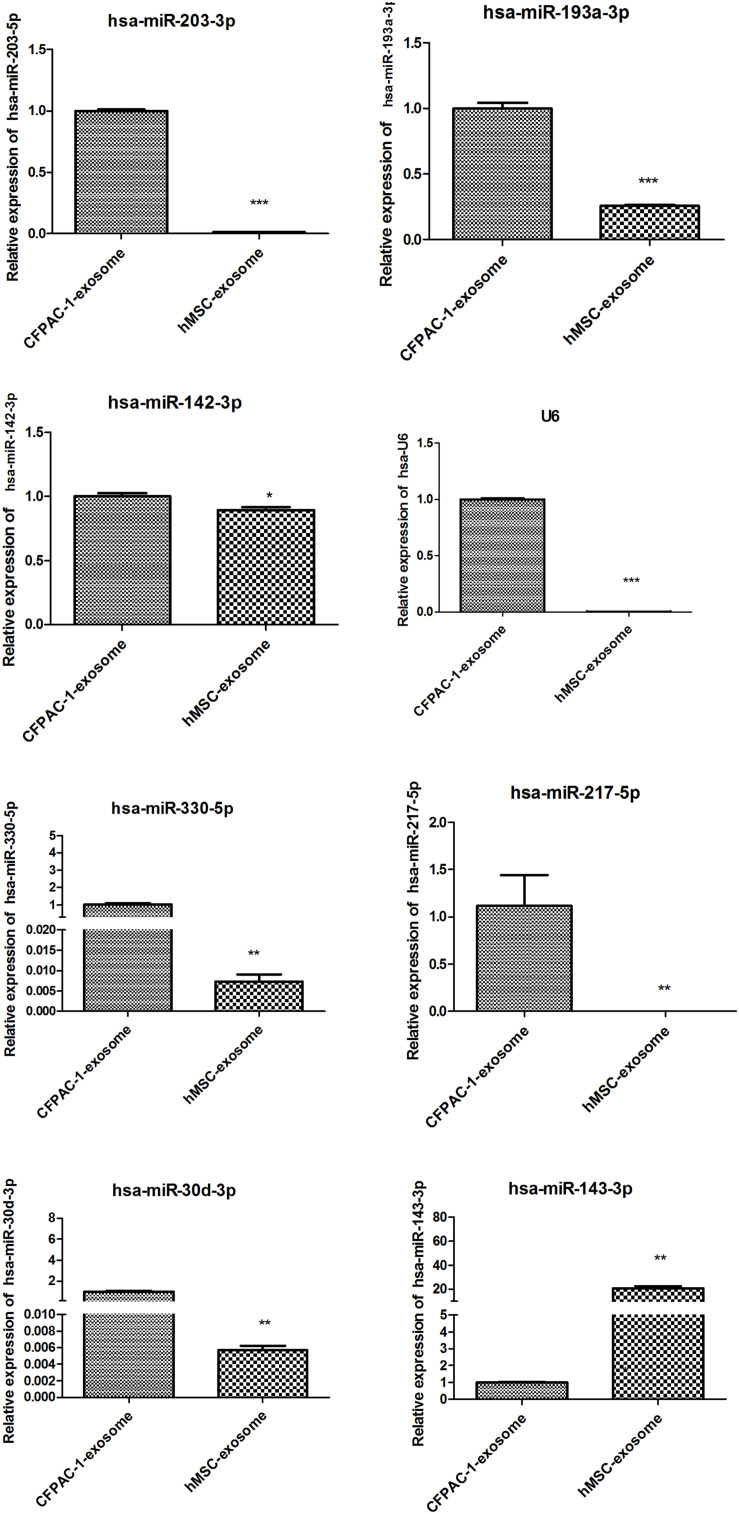
Detection of the relative expression of eight miRNAs by quantitative polymerase chain reaction (qPCR). *p < 0.05; **p < 0.01; and ***p < 0.001. hsa-miR-494-3p was stably expressed without significant difference in both CFPAC-1 and hMSC exosomes (p > 0.05), thus hsa-miR-494-3p was selected as the internal control.